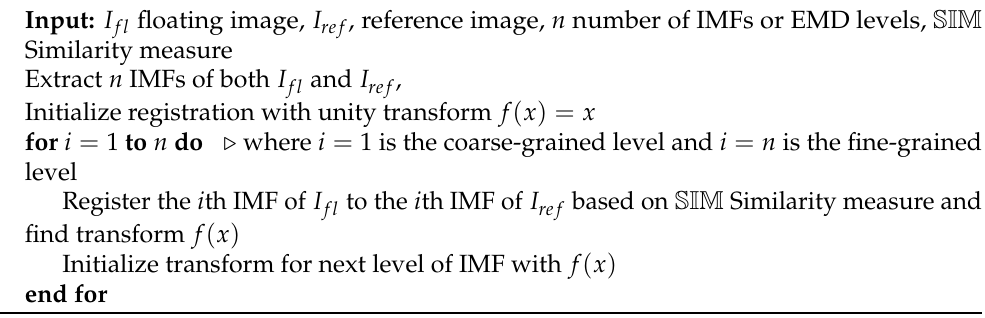
Algorithm 1 LR-EMD: Image Registration using EMD levels.